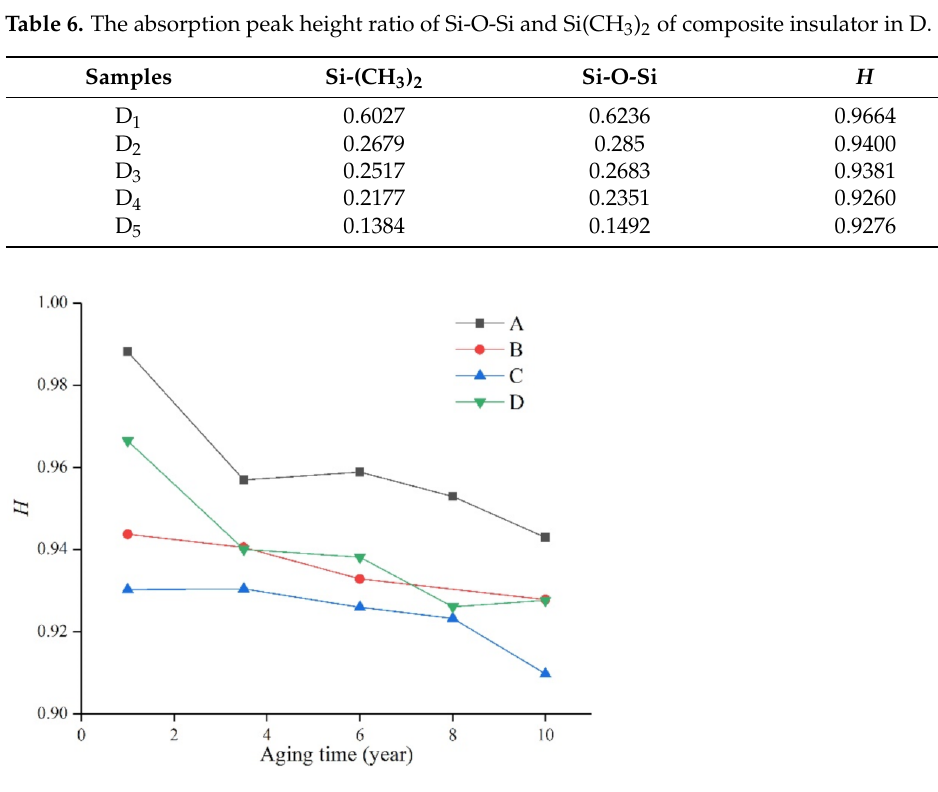
Figure 7. The relationship between H and operating